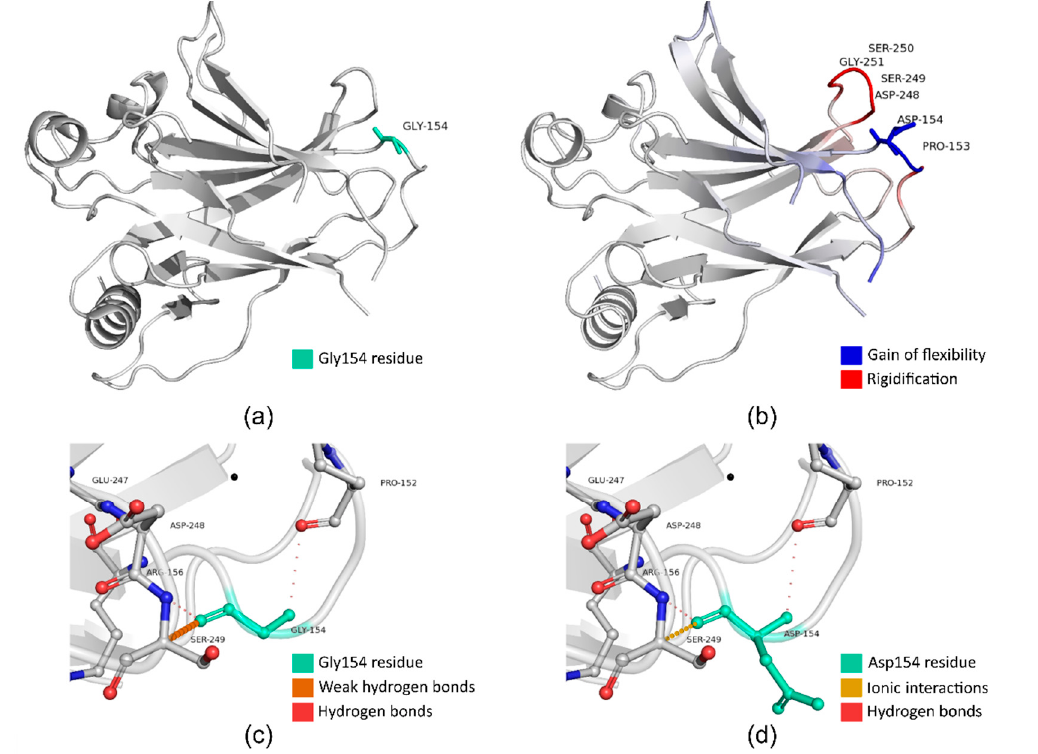
Figure 1. Structural and flexibility analysis of p.(Gly154Asp), a TP53 -predicted deleterious Variants of Uncertain Clinical Significance (VUS): ( a ) schematic representation of the location of the mutated Gly154 amino acid on the wild-type TP53 protein (Protein Data Bank (PDB) ID: 1GZH); ( b ) visual representation of the differences in vibrational entropy energy upon mutagenesis; ( c ) atomic interactions of the wild-type (Gly154) amino acid; and ( d ) atomic interactions of the mutant (Asp154) amino acid. Analysis was performed using the DynaMut webserver (http://biosig.unimelb.edu.au/dynamut/).